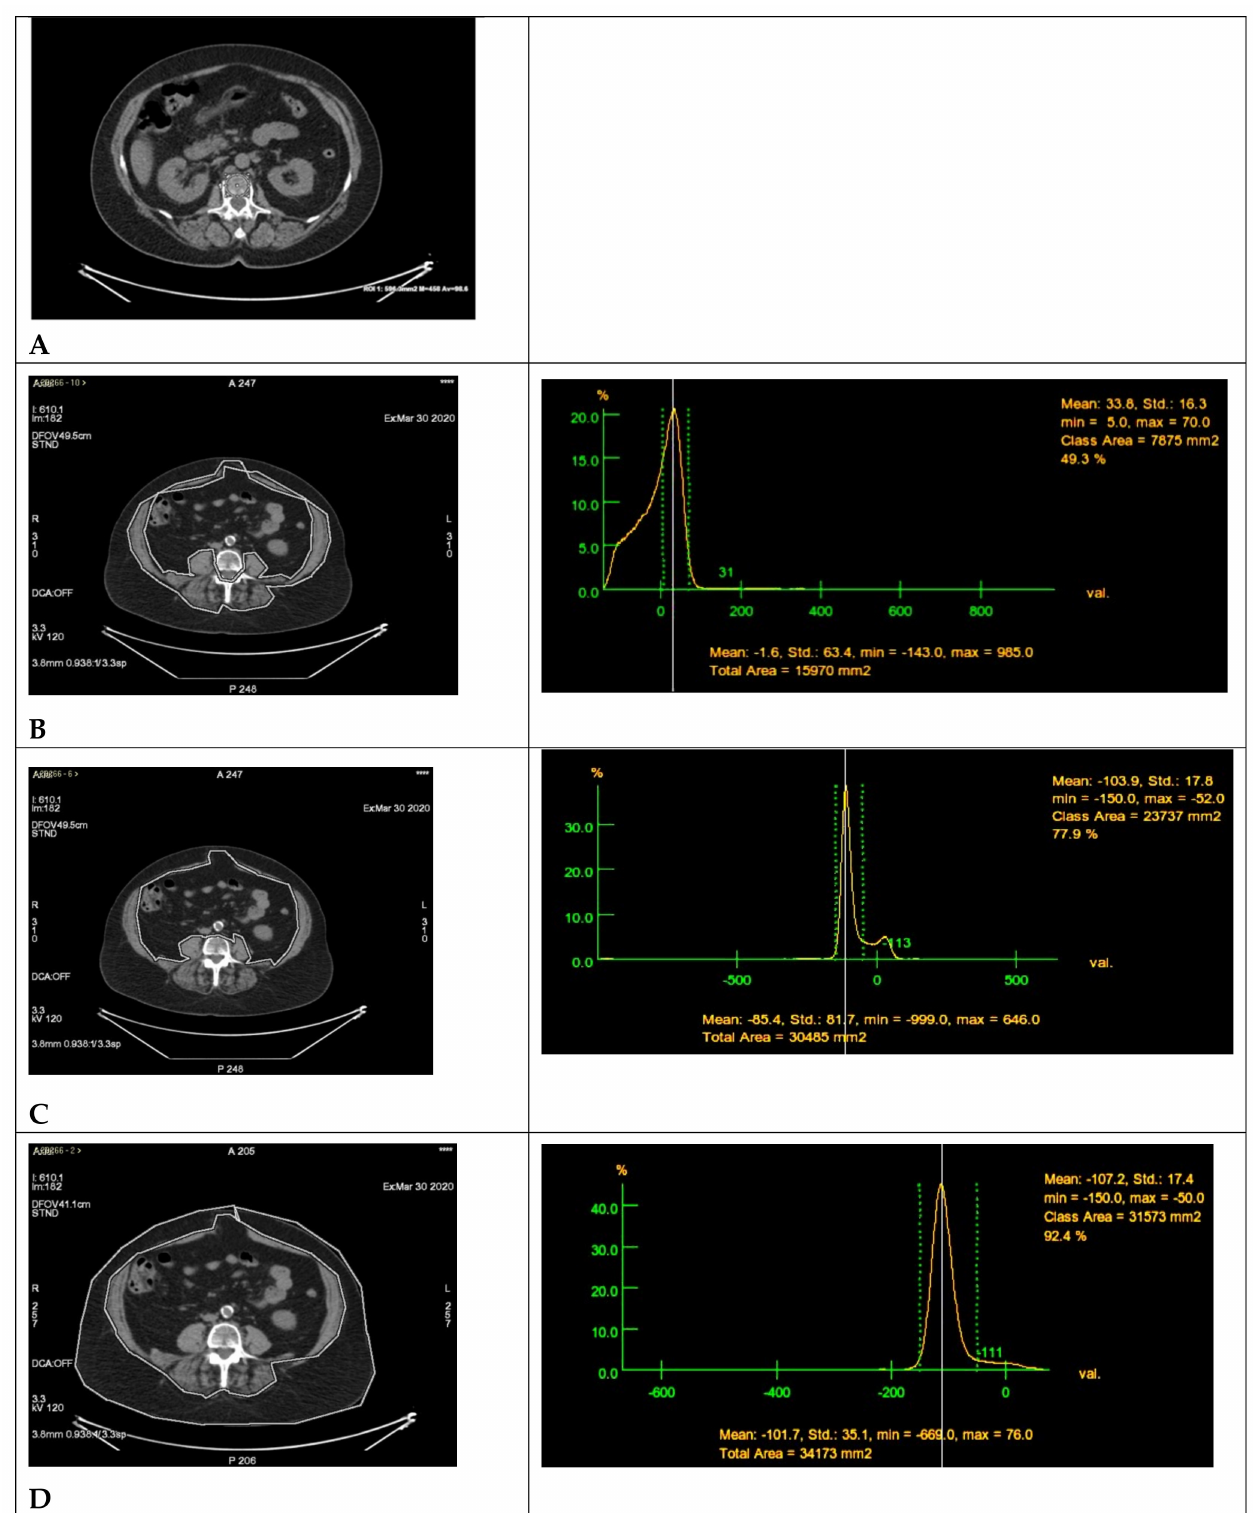
Figure 1. ( A ) BMD L1: BMD was measured in Hounsfield Units (HUs) and calculated with the Low-dose CT co-registration PET scan slice passing through the middle III of the L1 soma, placing an ROI with an area of approximately 600 mm 2 . ( B ) SMA L3: Low-dose CT co-registration PET scan with the slice passing through the middle III of L3 soma (on the left) and the ROI tissue density percent trend graphic (on the right) extrapolated using GE Adw Cross X software on a dedicated workstation (ADVANTAGE WORKSTATION 4.4. GE MEDICAL SYSTEMS). The SMA (measured in mm 2 , then converted to cm 2